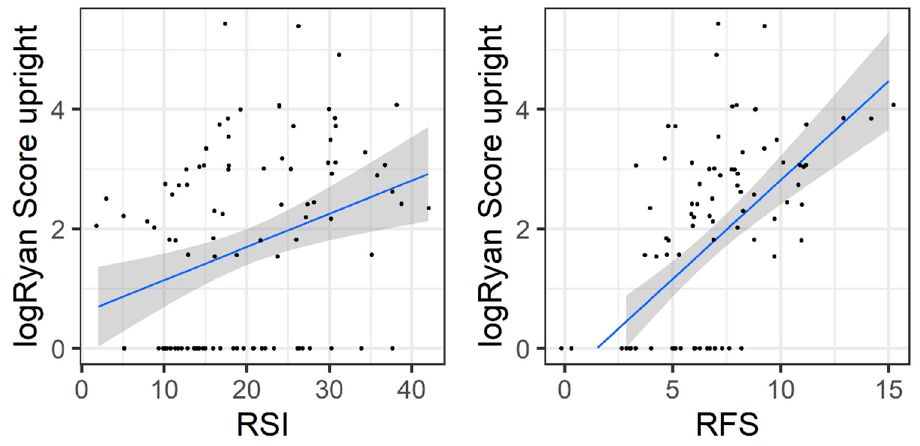
Figure 2. PL-RSI and PL-RFS scales against logRyan score measured in the upright position. The blue line is the fitted linear regression, while the grey area is the 95% confidence interval.